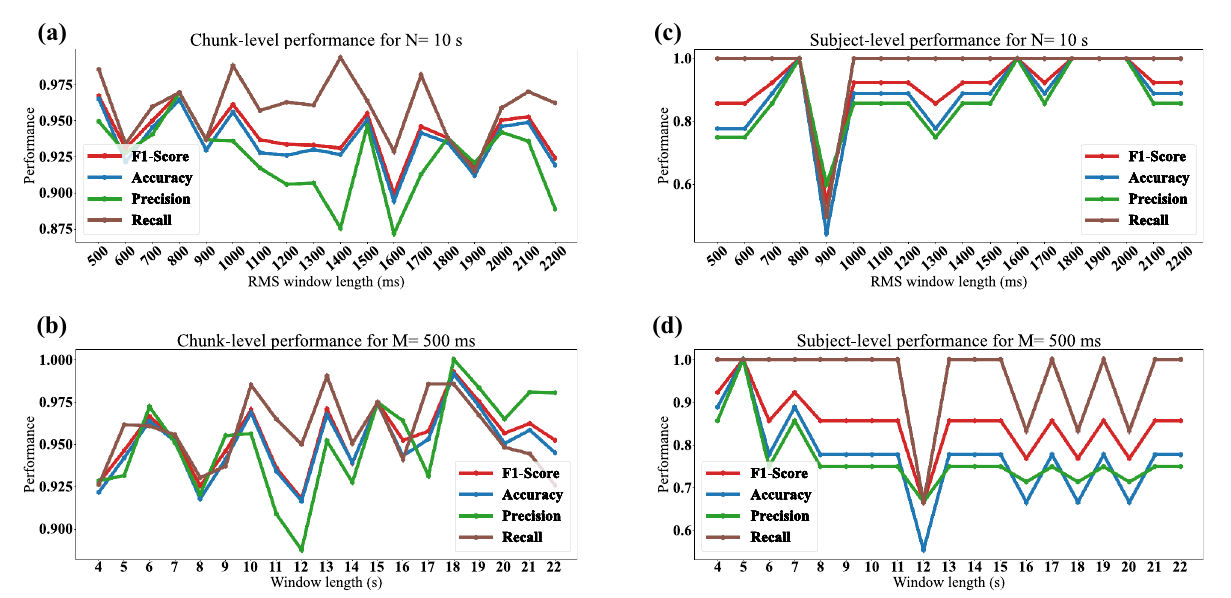
Figure 7. Performance evaluation of XGBoost for filters based on literature. ( a ) Chunk-level performance for N = 10 s, ( b ) chunk-level performance for M = 500 ms, ( c ) subject-level performance for N = 10 s, and ( d ) subject-level performance for M = 500